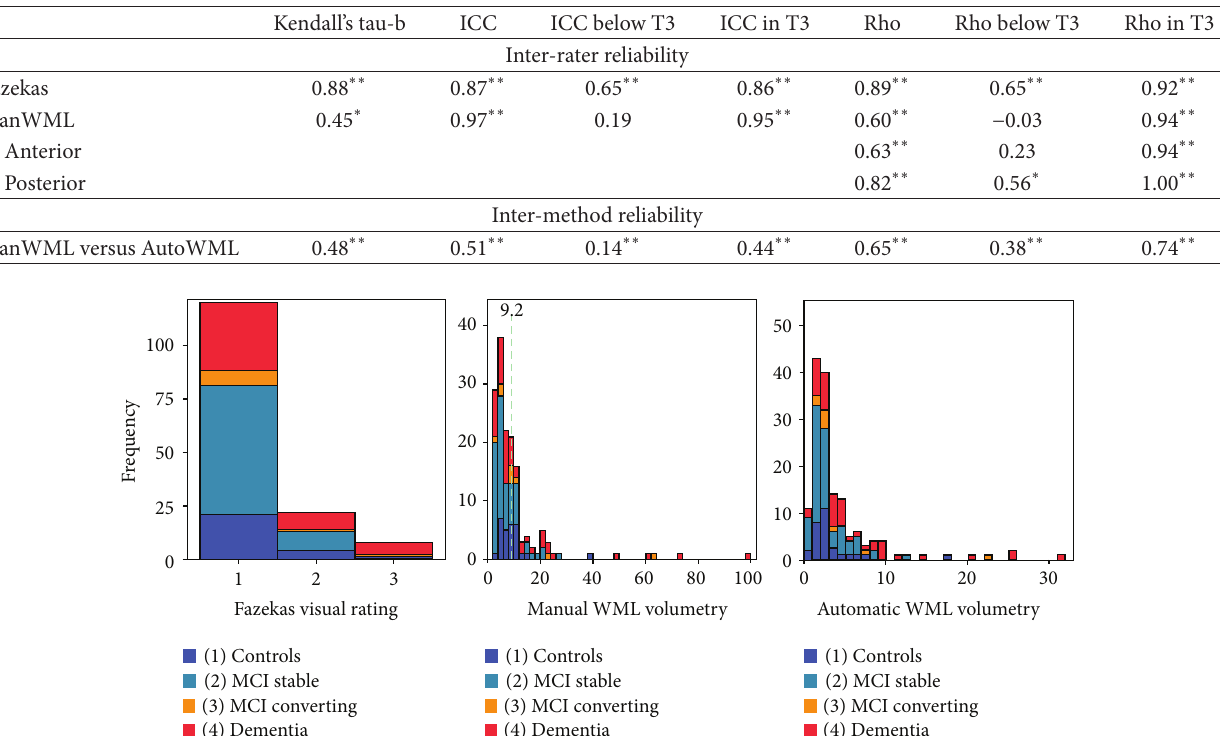
Correlation was signi�cant at the 0.05 level (2-tailed). ∗